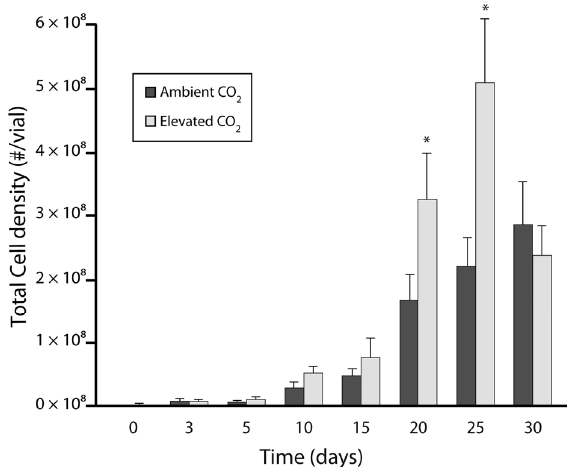
Figure 2. Density of cyanobacterial cells during grown of N. punctiforme over 30 days under ambient (430 ppm) and elevated (750 ppm) atmospheric CO 2 conditions. All data are plotted as mean ± SD; pairwise differences are shown using an asterisk symbol (*).